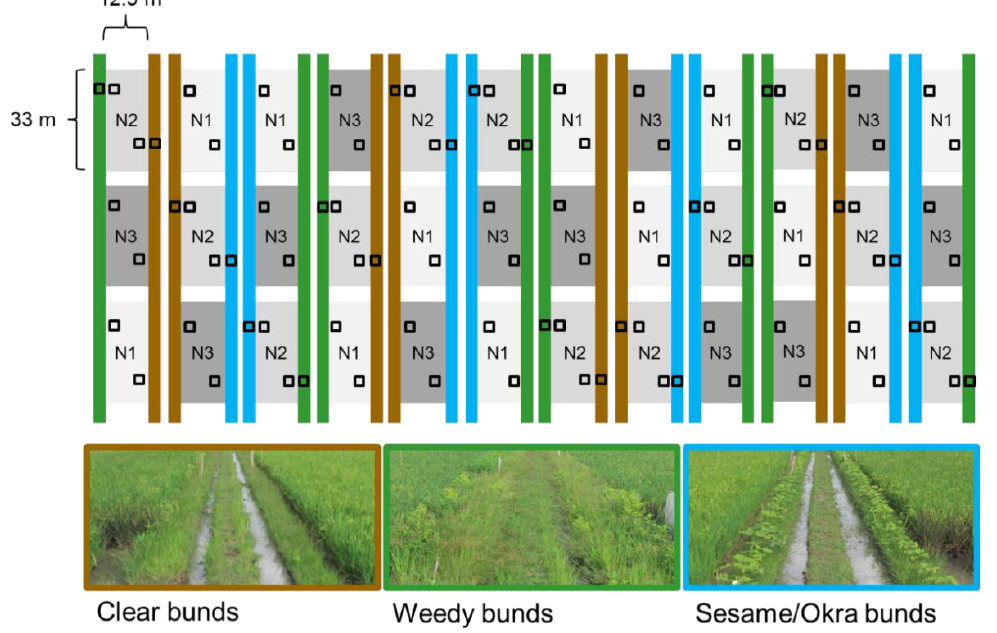
Figure 1. Field set-up during the 2011 wet season indicating fertilizer levels (N1 = 0 added nitrogen, N2 = 60 Kg ha − 1 of added nitrogen, N3 = 150 Kg ha − 1 of added nitrogen) and bund treatments (brown = clear, green = weedy, and blue = sesame / okra bunds). All fields were planted with IR66. Squares indicate approximate sampling points. Photographs indicate the appearance of bunds during rice crop growth. Note the central levees and sub-drainage channels between adjacent treatment bunds.